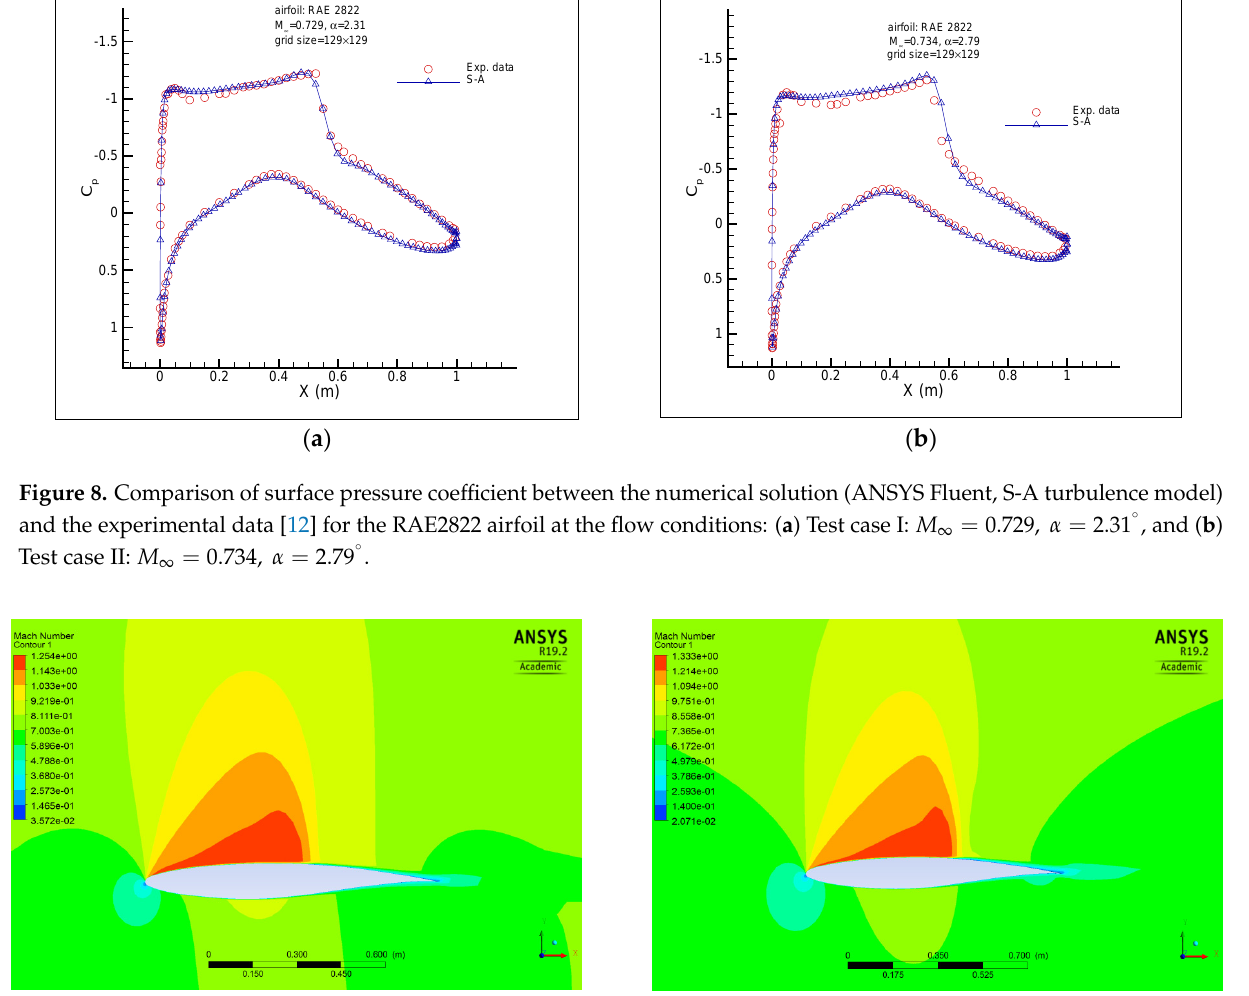
Figure 9. Mach number distribution around the RAE 2822 airfoil. Table 1. Numerical simulation of transonic turbulent flow over the RAE 2822 airfoil using the software ANSYS Fluent.